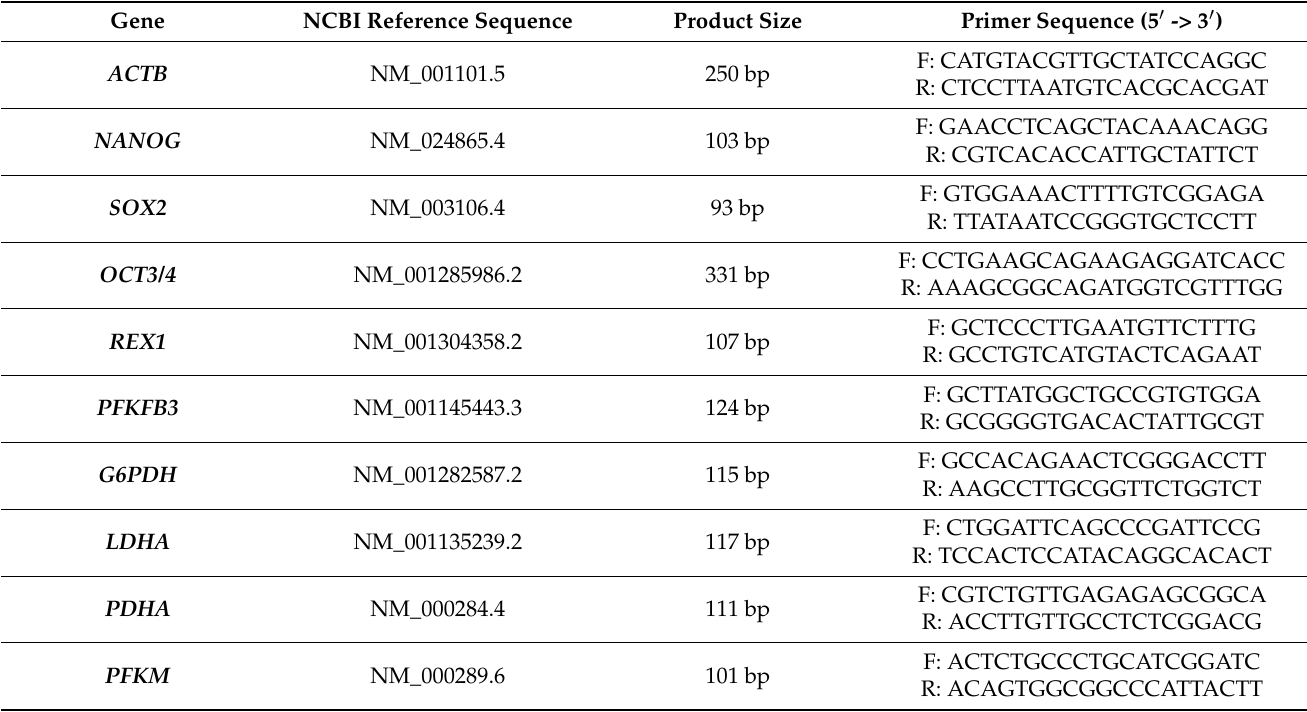
Table 3. Primers sequences used with